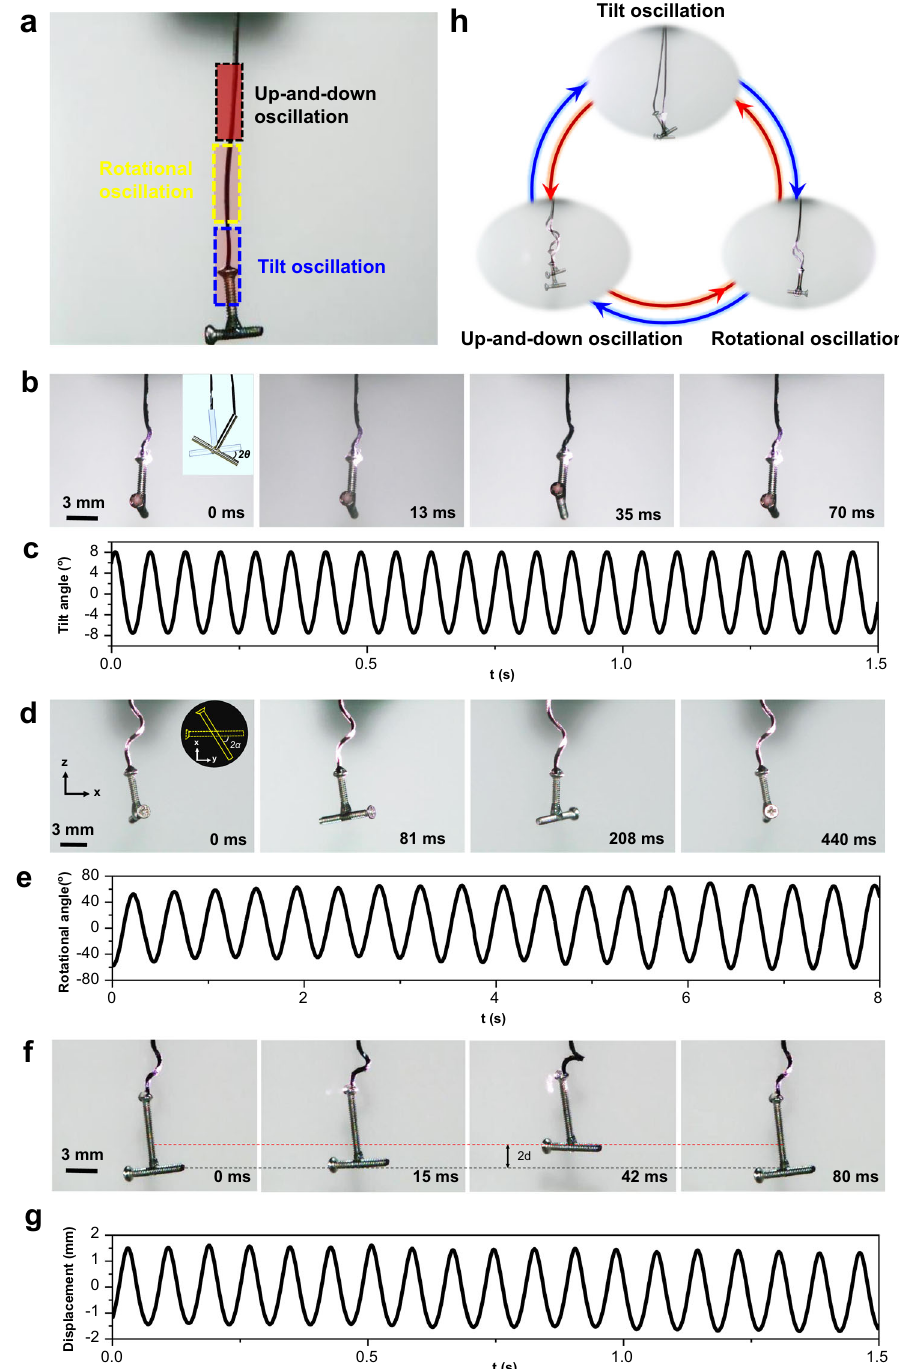
Fig. 2 Phototunable self-oscillations. a Photograph showing the location and intensity of NIR spot that triggers three basic self-oscillations. The shade of red color enclosed by dashed boxes schematically indicates the intensity of the light. With the same size of the NIR spot, the thresholds of light intensity must be met to generate three self-oscillations (see Supplementary Fig. 6). The threshold required to produce up-and-down oscillation is the highest among the three basic self-oscillations. To gain tilt oscillation, the connection part between the hanging object and the SWFA must be irradiated. b , d , f Snapshots experimentally showing three basic self-oscillations: tilt oscillation (Supplementary Movie 2), rotational oscillation (Supplementary Movie 3), and up-and- down oscillation (Supplementary Movie 4). c , e , g Tilt oscillation, rotational oscillation, and up-and-down oscillation are quanti fi ed through tilt angle ( θ ), rotational angle ( α ), and displacement ( d ) with time, respectively. h Photographs showing controllable and reversible switching among the three basic oscillation modes (Supplementary Movie 5). The T-shaped load is used to clearly exhibit self-oscillations. The weight of the hanging object is 62mg. The intensity of NIR light is ~3.5 W cm − 2 for tilt oscillation and rotational oscillation, and ~5W cm − 2 for up-and-down